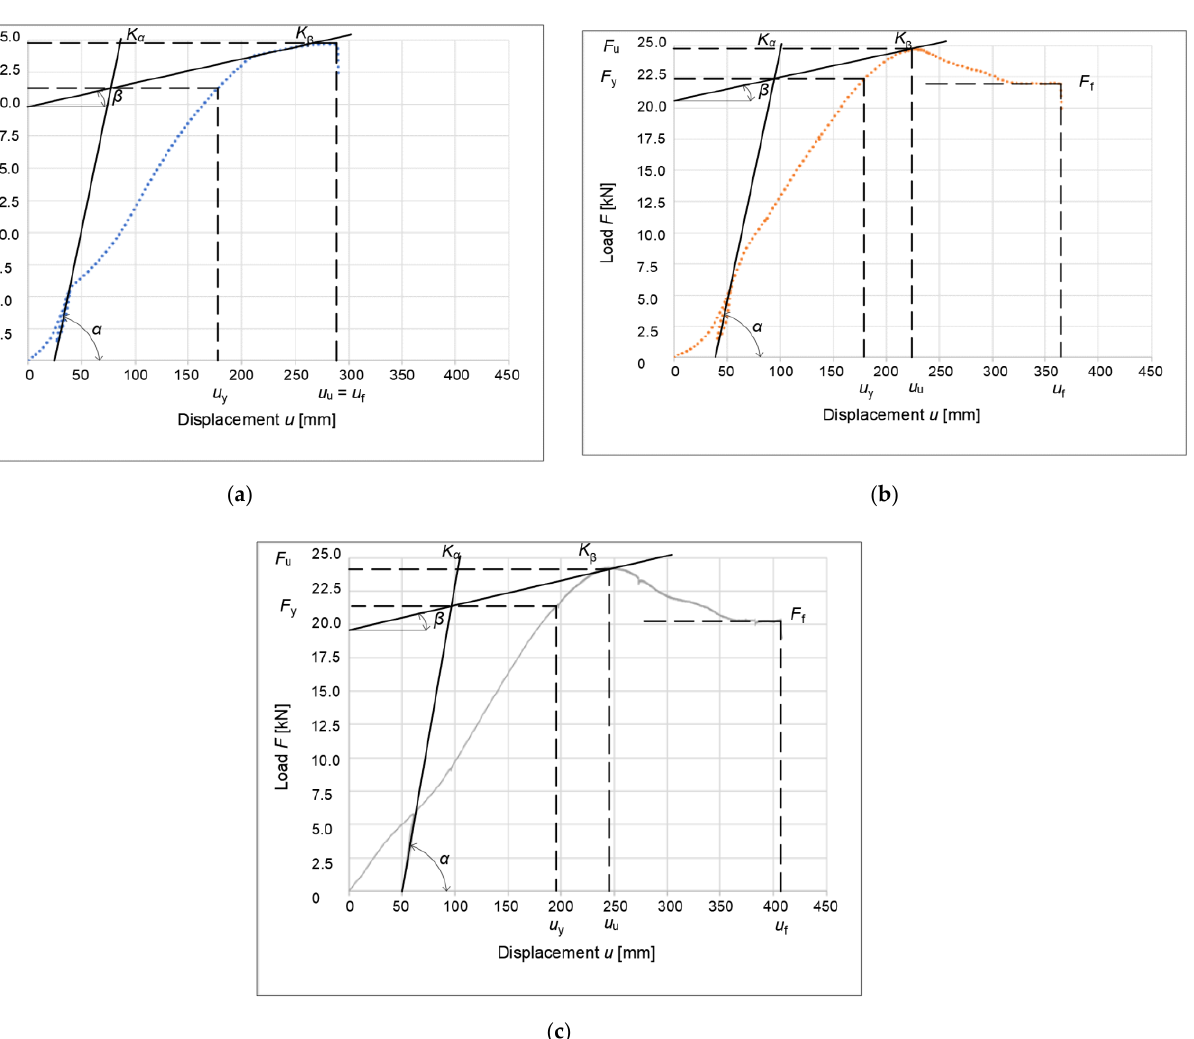
Figure 20. Graphical representation of the yield strength of a connection formed with screws ac- cording Yasamura and Kawai (1998): ( a ) unreinforced specimen; ( b ) reinforced partitions; and ( c ) reinforced rung and struts